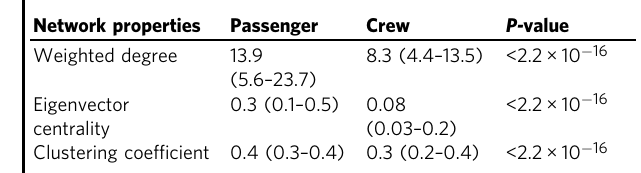
Table 2 Network properties of passengers and crew